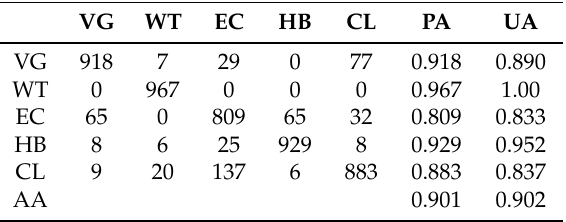
Table 8. Confusion matrix of the proposed method in the second area.